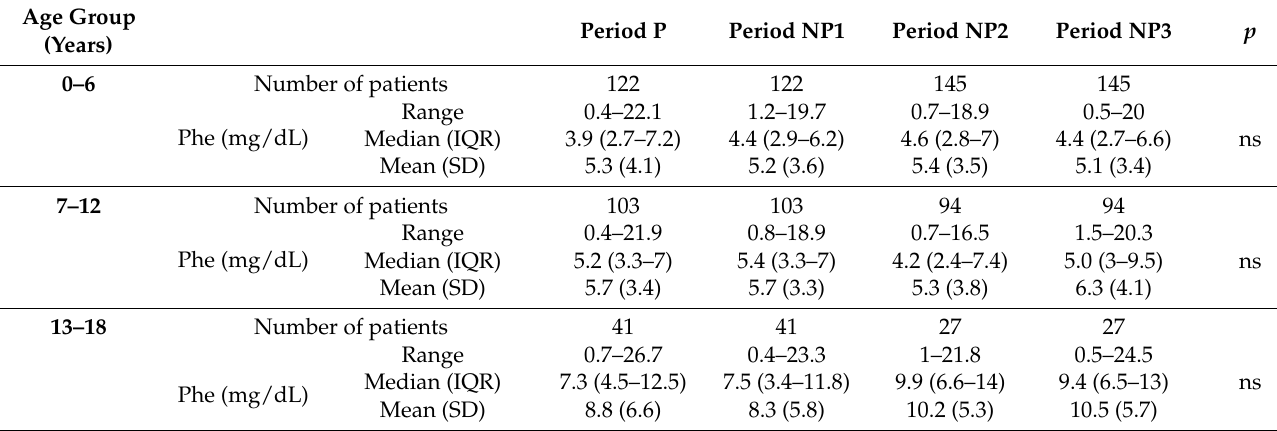
Table 4. Phenylalanine (Phe) concentrations in the assessed time intervals (periods P and NP1 to NP3) in 266 patients who completed the Phe test in all four assessed time